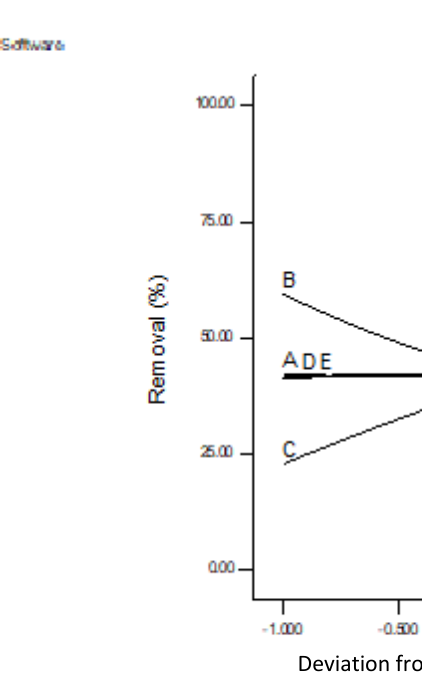
Fig. 3: The perturbation graph for experiments’ parameters on CIP removal efficiency under RSM method